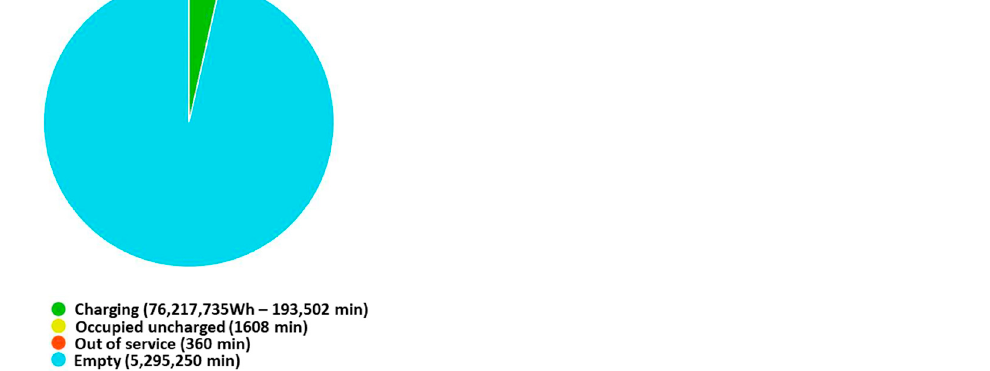
Figure 10. The usage of EV charging station in Unirii Square from January 2019 to June 2022.